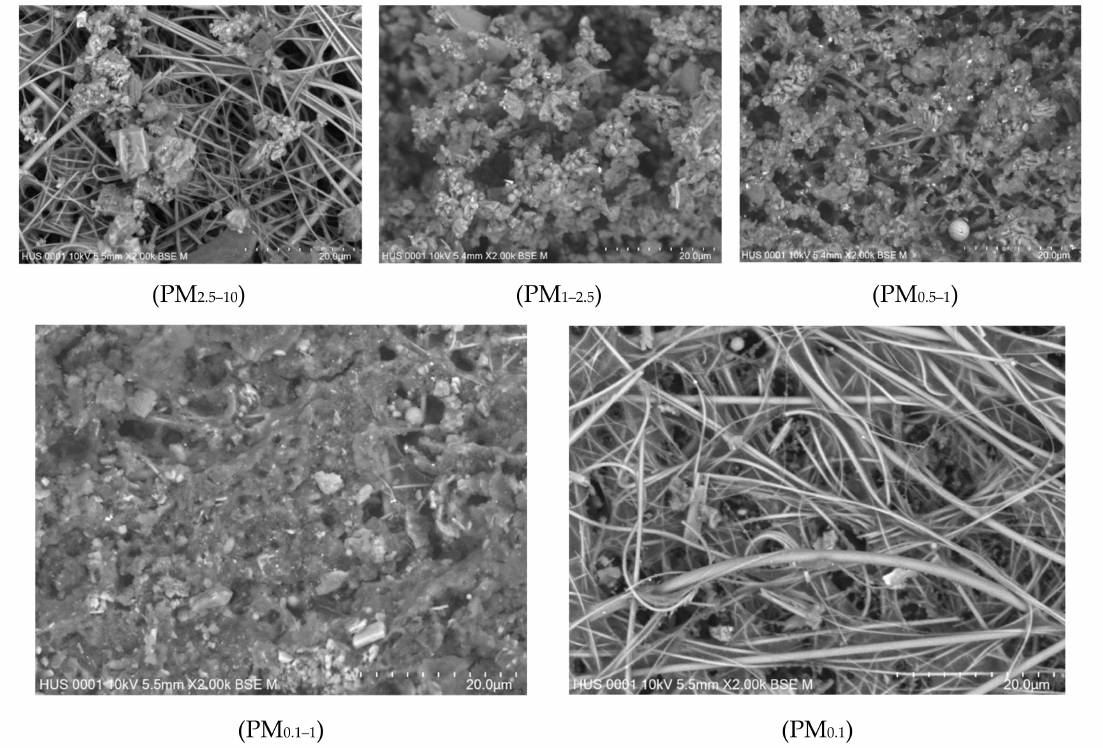
Figure 5. SEM images of outdoor airborne particles (PM 2.5–10 , PM 1–2.5 , PM 0.5–1 , PM 0.1–1 , and PM 0.1 ) collected during the class at